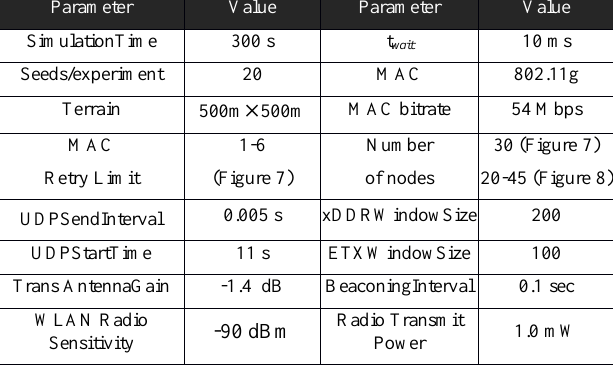
Figure 6: Simulation parameters